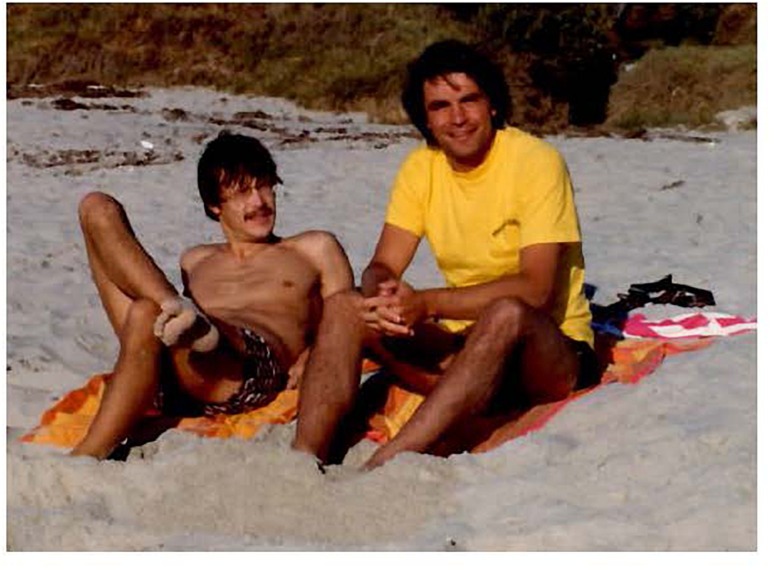
Dr. Klaus T. Preissner (left) and the author (right) at Windansea Beach, La Jolla, California (ca. 1980).